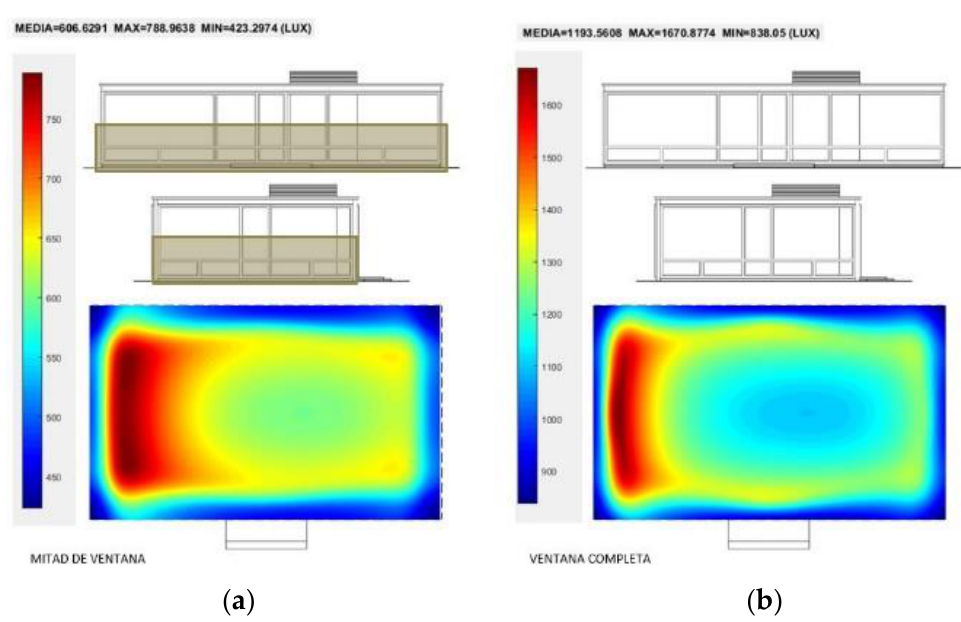
Figure 14. Glass House results in plan. ( a ) Half height windowsill at 1.8 m. ( b ) Full window.